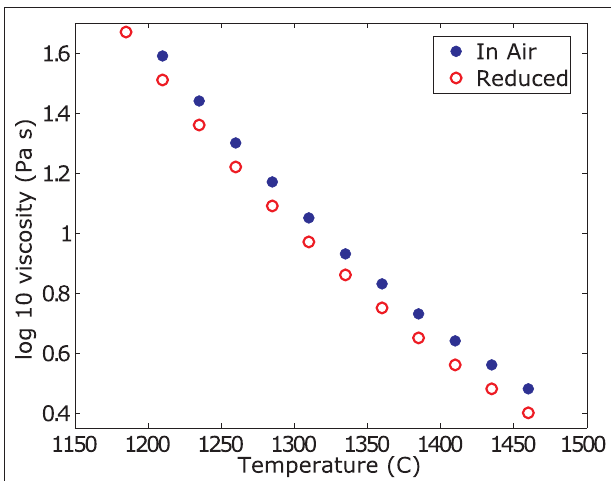
FIGURE 2 | Liquid viscosity data. Summary of the super-liquidus viscosity measurements in air and at reduced conditions. The melt viscosity at reduced conditions is 0.08 log units lower than in air. For ease of comparison and reporting, the data are reported as values interpolated at the same temperatures.